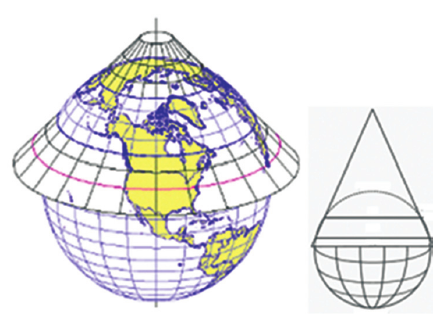
Fig. 9. Transformation of oblique spherical circle to the secant conical surface (Bunch 2004) One may find the conical model as a base in some cartographic projections applied in constructing the charts. Comparing the value of (cid:83) (cid:4) function for both